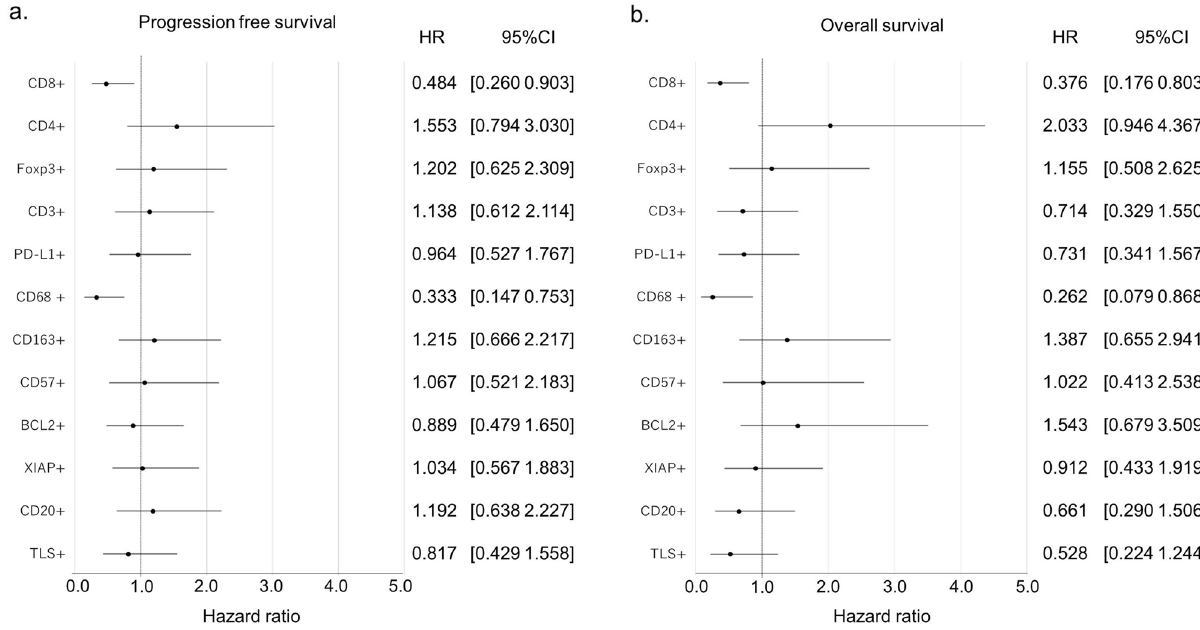
Figure 4. Forest plot diagram. ( a ) Hazard ratio (HR) with 95% confidence interval association between progression-free survival (PFS) and IHC staining status. ( b ) Hazard ratio (HR) with 95% confidence interval association between overall survival (OS) and IHC staining